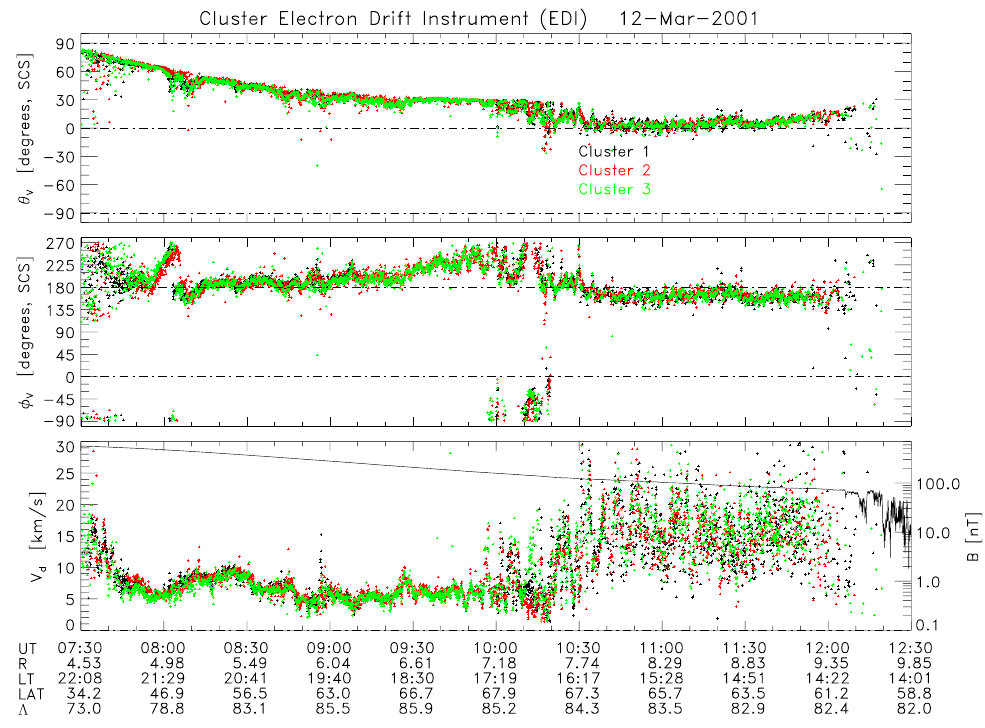
Fig. 6. EDI spin-resolution data from three spacecraft for the outbound pass on 12 March 2001, 07:30–12:30 UT. The top two panels show the elevation and azimuth angles of the drift velocity, 2 v and 8 v , in SCS coordinates. Because the flow is towards 180 ◦ much of the time, the scale for the azimuth is shown from − 90 ◦ to 270 ◦ . The third panel shows the magnitude of the drift velocity, and, as a black line, the magnetic field magnitude measured by FGM on SC1 for reference. The spacecraft position (in GSE) and invariant latitude, given along the bottom, are for SC1. The data are plotted on the same scale for the three spacecraft and are placed at spin-center times, which are not identical because the spins of the Cluster spacecraft are not synchronized. As the green symbols (for SC3) are plotted last, they are the only ones visible in regions of close